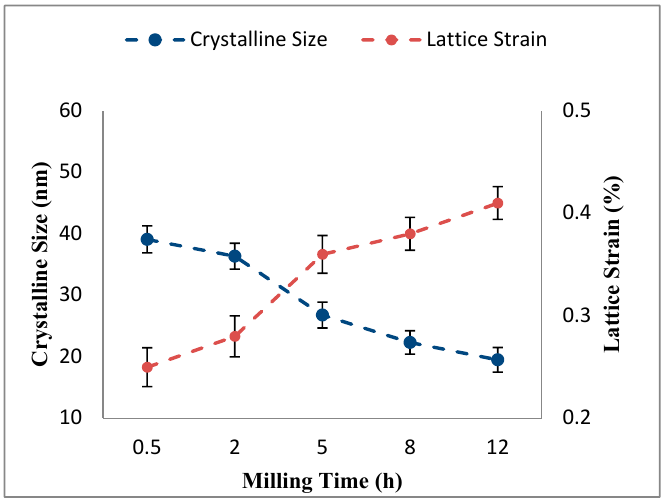
Figure 5. Variation of crystalline size and lattice strain of milled Al-5Al 2 O 3 as a function of milling time.